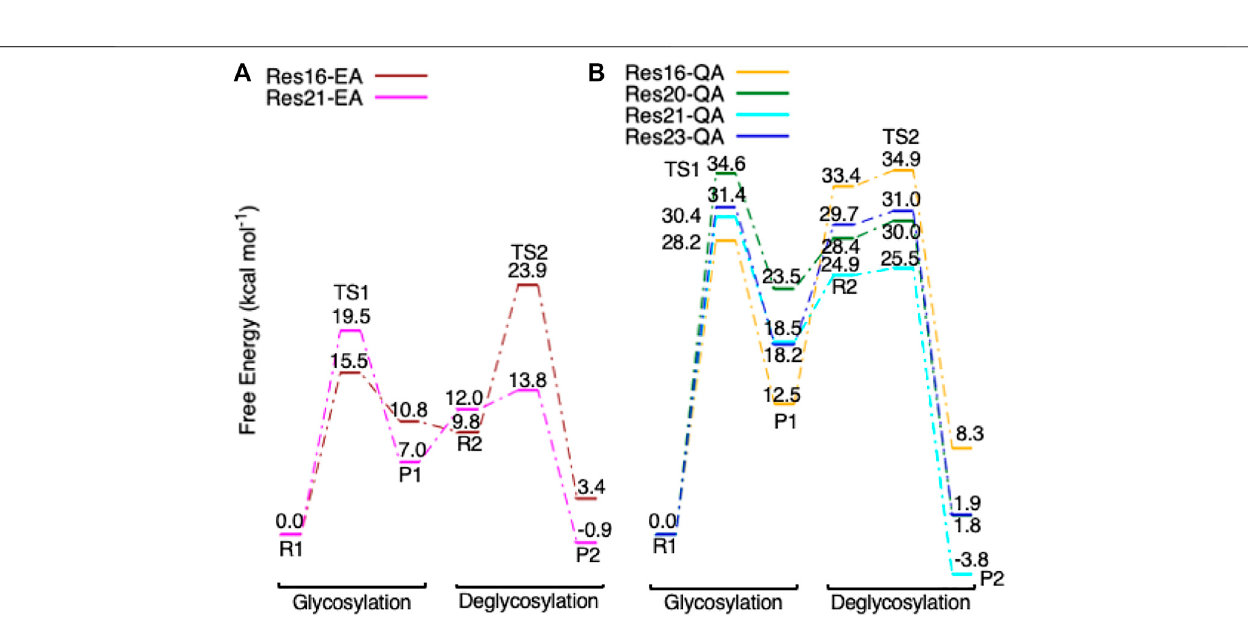
FIGURE 6 | (A) Free energy diagram of the glycosylation and deglycosylation for models Res16-E (brown) and Res21-E (magenta) which are built using PDB 8CEL(wild-typeprotein),and (B) ,models Res16-Q (orange), Res20-Q (green), Res21-Q (cyan),and Res23-Q (blue)whicharebuiltusingPDB4C4C(E217Q,mutated